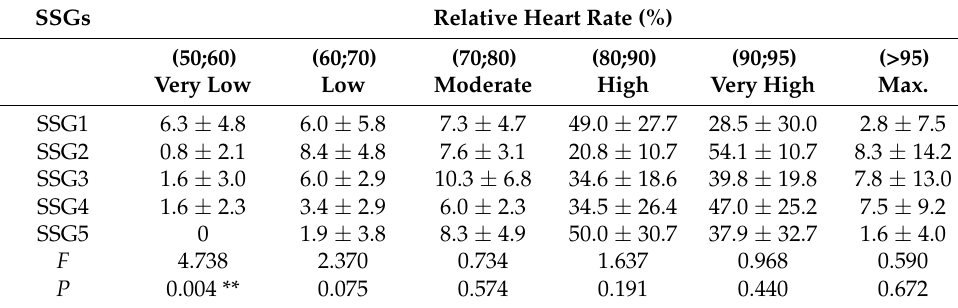
Table 3. Heart rate percentage in different forms of small-sided games.